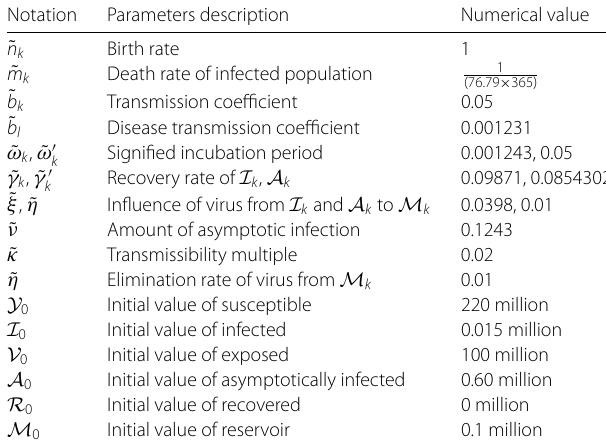
Table 1 Description of the parameters used in model